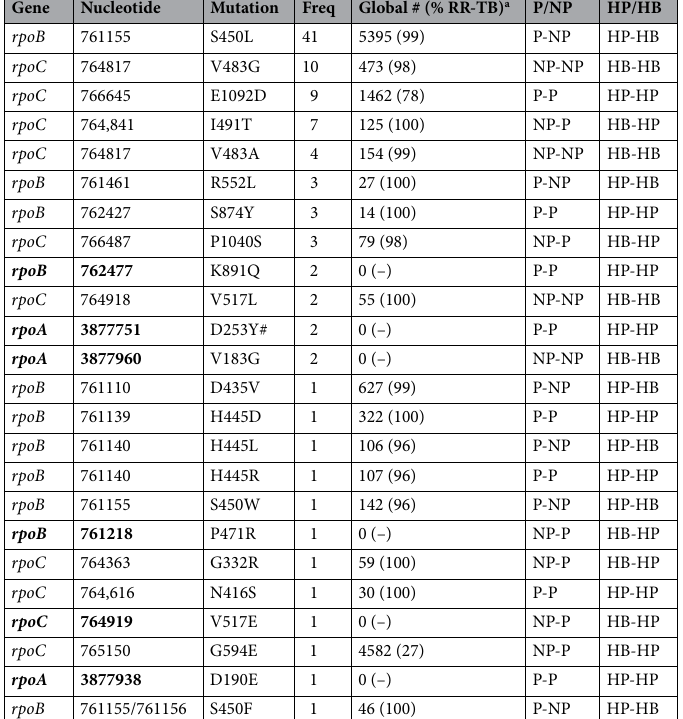
Table 2. Non-synonymous mutations in rifampicin candidate genes of M. tuberculosis. Bolded are unreported by Napier et al. (~ 35 k). RR-TB rifampicin-resistant TB, P polar, NP non-polar, HP hydrophilic, HB hydrophobic. a From Napier et al. (~ 35 k).